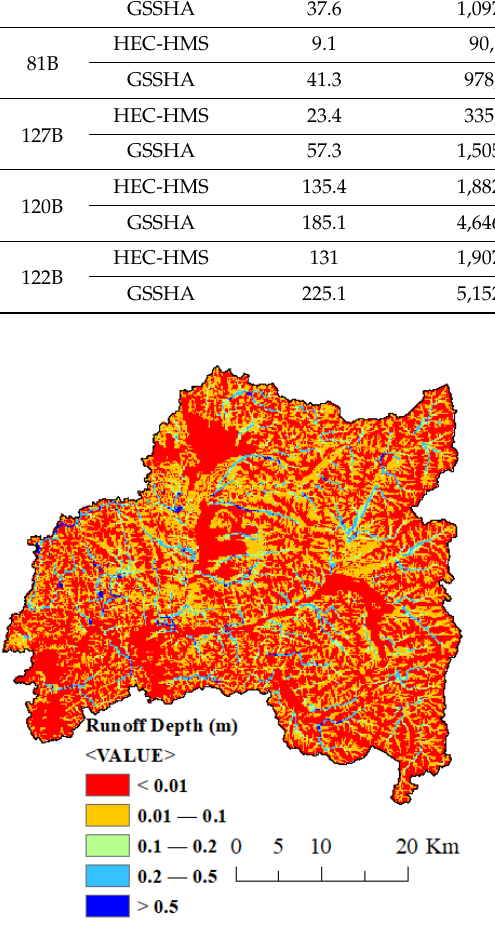
Figure 17. Distributed surface runoff depth map produced by GSSHA.